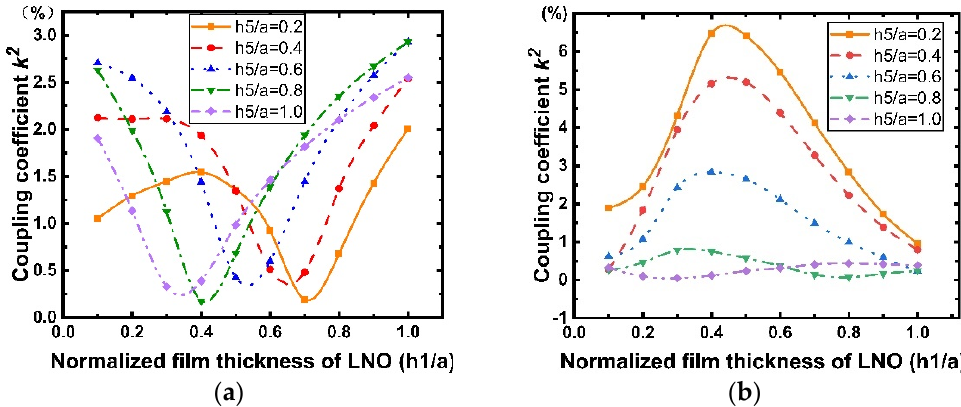
Figure 12. Dispersion curves of the Rayleigh and Sezawa waves electromechanical coupling coef- ficient ( k 2 ) calculated for various values of h 1 / a for the structure SiO 2 /IDT/LiNbO 3 /diamond/Si. ( a ) Rayleigh mode; ( b ) Sezawa mode.